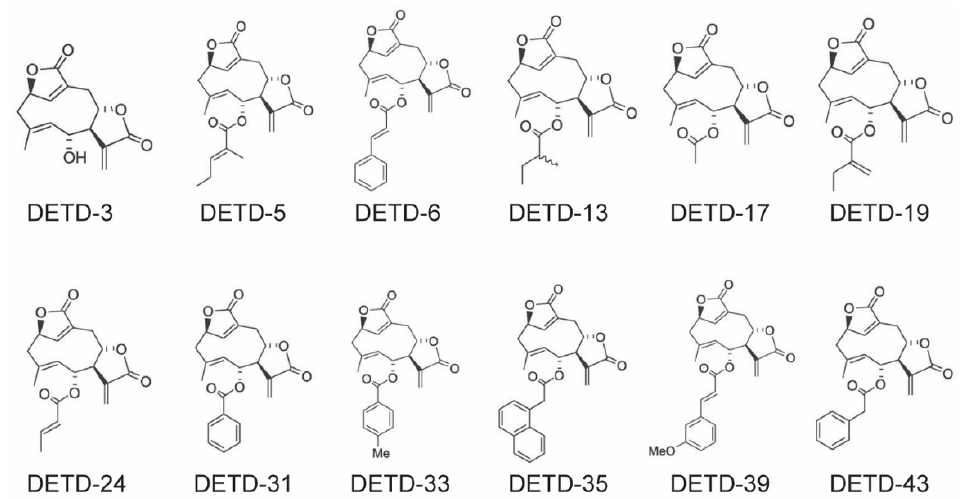
Figure 7. Chemical structures of DET derivatives.